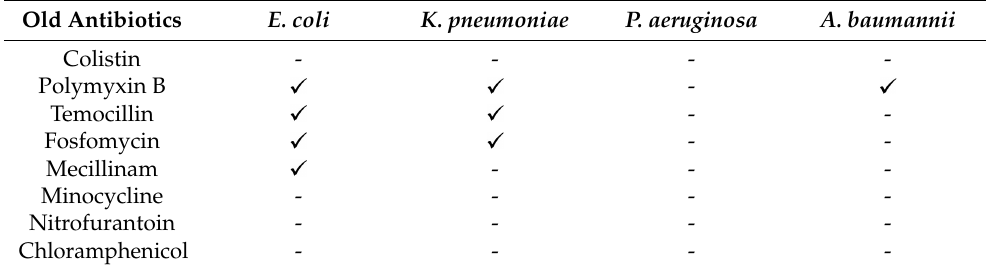
Table 4. Summary of old antibiotics with clinical potential against gram (-) isolates. Old